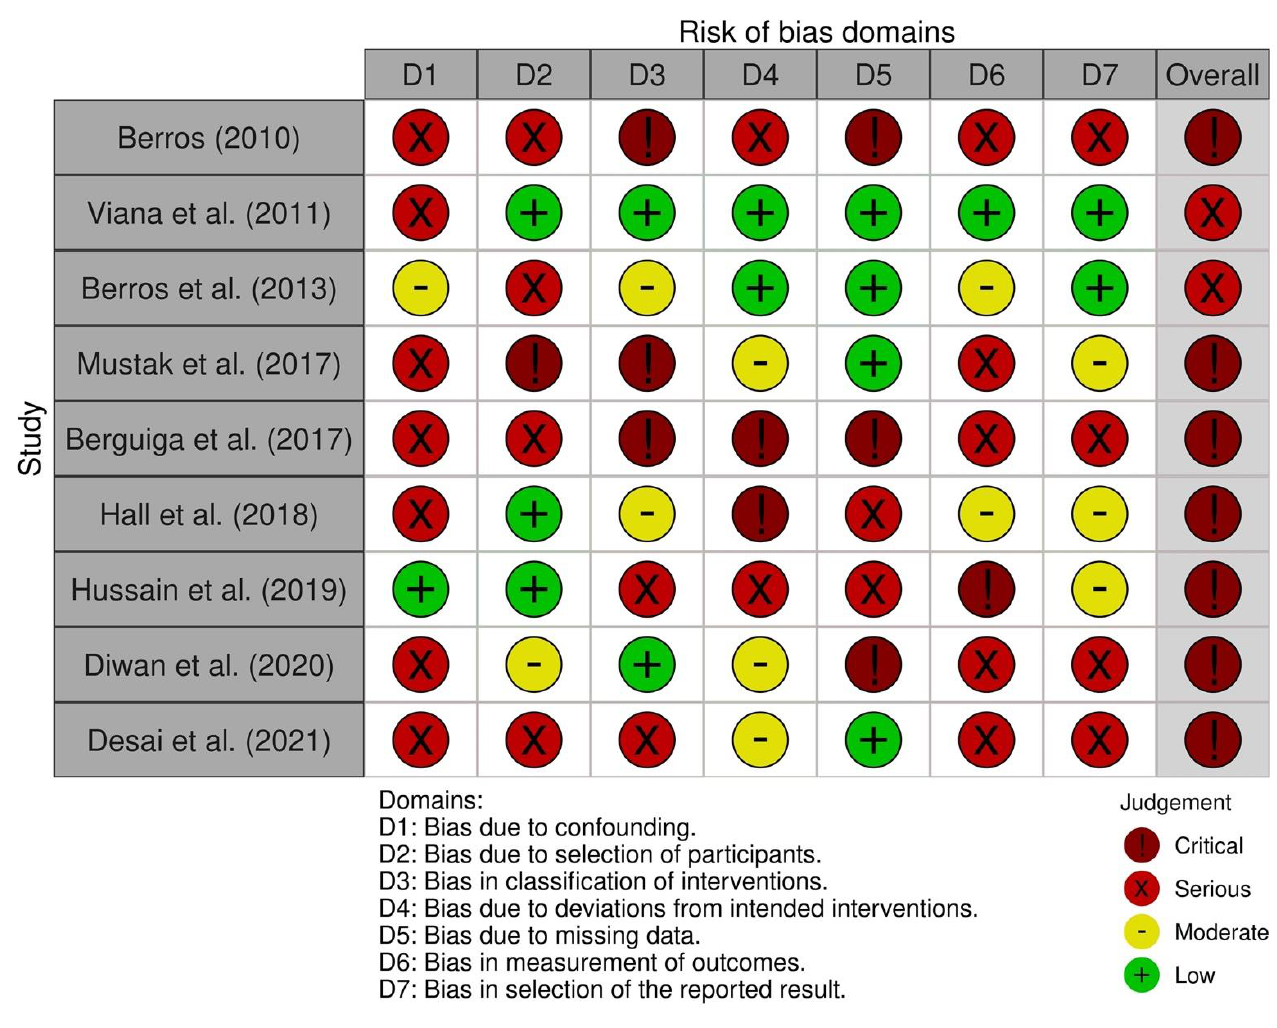
Figure 2. ROBINS-I Traffic Light Plot bias assessment.